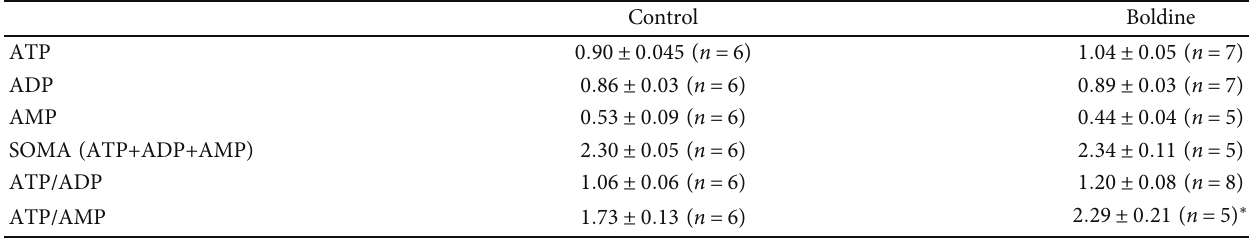
Table 1: E ff ects of boldine (200 μ M) on the adenine mononucleotide contents of the livers from fasted rats. The liver perfusion and the analytical procedures were described in the Materials and methods. In control livers, 2 mM L-lactate was infused alone from 10 to 56 minutes; the test livers were perfused with 2 mM lactate from 10 to 36 minutes and with 200 μ M boldine from 36 to 56 minutes. At 56 minutes, the livers were freeze-clamped in liquid nitrogen, and the adenine nucleotides were extracted with cold perchloric acid. Values are means ± meanstandard errors of 4 to 5 experiments. Asterisks ( ∗ ) indicate statistical signi fi cance in comparison with the control condition according to the Student-Newman-Keuls post hoc testing ( p ≤ 0 : 05 ).